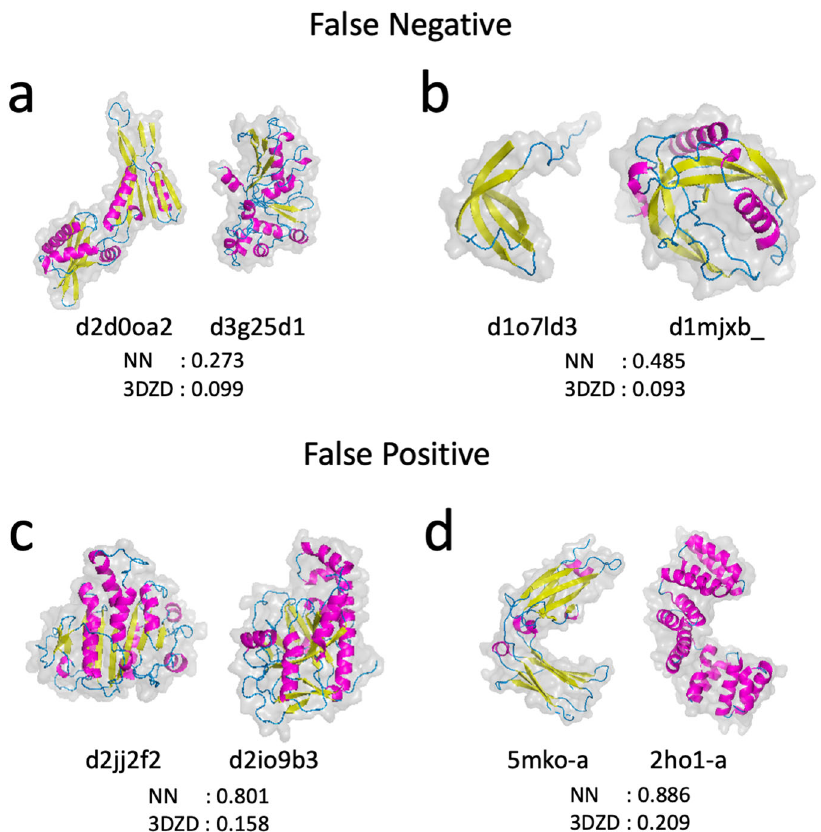
Fig. 4 Examples of protein pairs that were misclassi fi ed by 3D-AF-Surfer. Four protein structure pairs are shown with scores from 3DZD-NN and 3DZD. 3DZDs of the main-chain atoms were used. The two numbers below each protein pair are scores of the two structures by 3DZD-NN and 3DZD. The pairs on panel a and b are cases where both 3DZD-NN and 3DZD considered the two proteins to belong to different SCOP folds but they actually do not. a d2d0oa2 and d3g25d1 belong to the Ribonuclease H-like motif fold (SCOP code: c.55). The scores of 3DZD-NN and 3DZD for this pair was 0.273 and 0.099, respectively, both of which were lower than threshold values used (0.6 and 0.1) and thus considered as different folds. b d1o7ld3 and d1mjxb_ belong to OB fold (b.40). The two pairs on panel c and d are examples of false positives, where 3D-AF-Surfer suggested that each pair belonged to the same fold, but they actually do not. c d2jj2f2 belongs to P-loop containing nucleoside triphosphate hydrolases (c.37) while d2io9b3 belongs to ATP-grasp (d.142). d PDB ID: 5mko-A is a β class structure while 2ho1-A is an α -class structure. These two structures do not have a SCOP ID assigned at time of writing. This example is taken from the paper that reported ZEAL 37